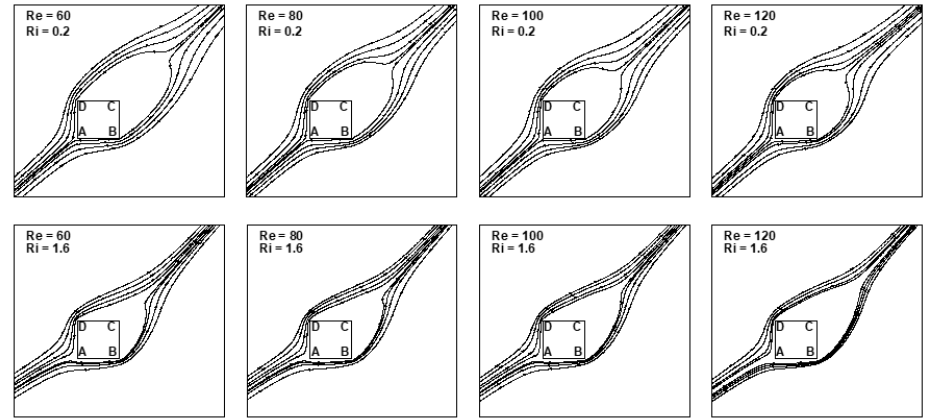
≤ Re ≤ 120, Ri = 0.2 and 1.6 at α = 45 ◦